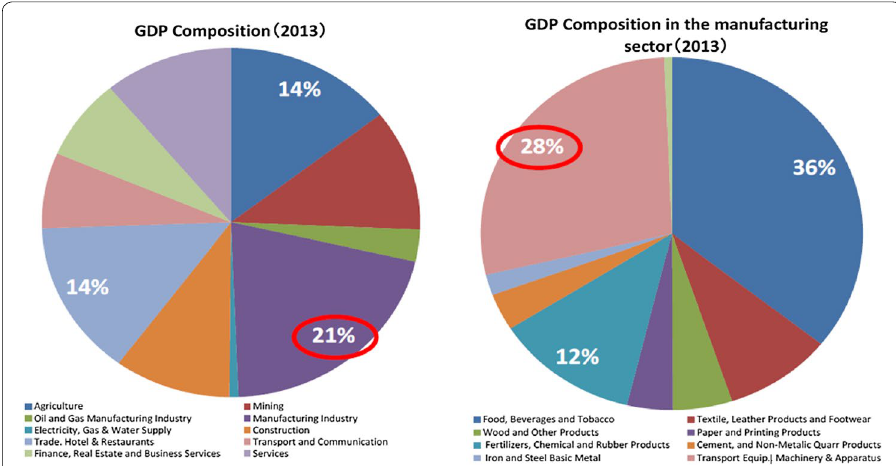
Fig. 1 Contribution of manufacture and automotive industry to Indonesian economy. Source : Central Agency of Statistics of Indonesia (BPS) in JETRO (2015)